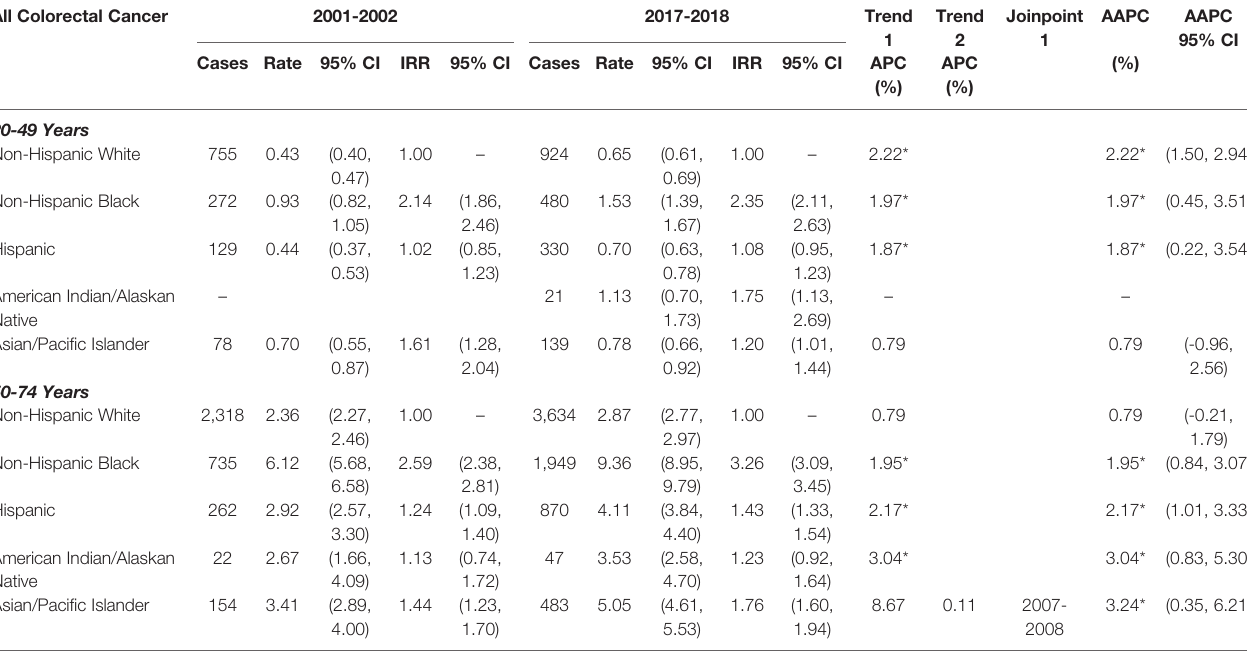
TABLE 4 | Age ‐ adjusted early ‐ onset (20-49 years of age) and late ‐ onset (50-74 years of age) colorectal neuroendocrine rates per 100,000 person ‐ years. All Colorectal